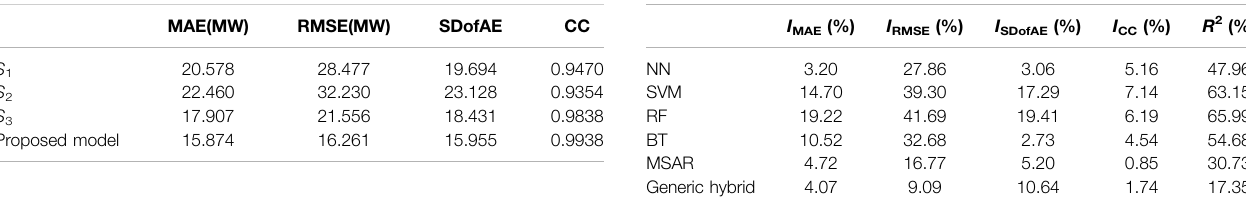
TABLE 3 | Improvement coef fi cients of traditional prediction